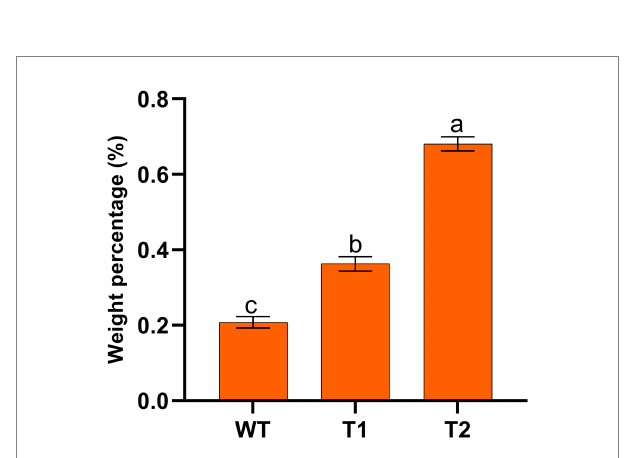
FIGURE 8 Mass percentage of astaxanthin in wild type and